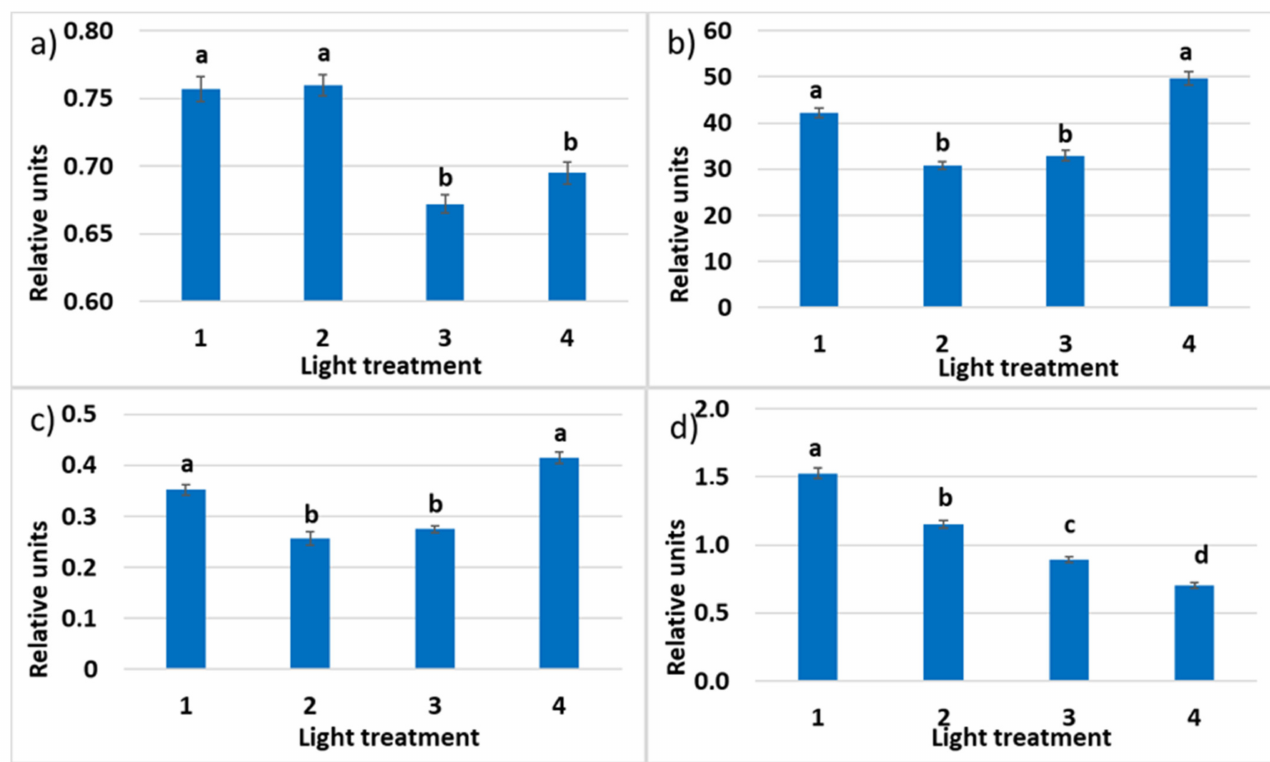
Figure 7. ( a ) Maximum quantum efficiency (Fv/Fm) of photosystem II (PSII); ( b ) photochemical electron transport rate (ETR); ( c ) relative PSII operating efficiency ( Φ PSII); ( d ) chlorophyll a non-photosynthetic quenching (NPQ) in the leaves of raspberry plants grown under various red (R 660 )–far-red (FR) light ratio. Means ± standard error (SE); means followed by the same letter were not different at p ≤ 0.05. Treatment 1—0% R 660 + 100% FR 730 ; Treatment 2—30% R 660 + 70% FR 730 ;